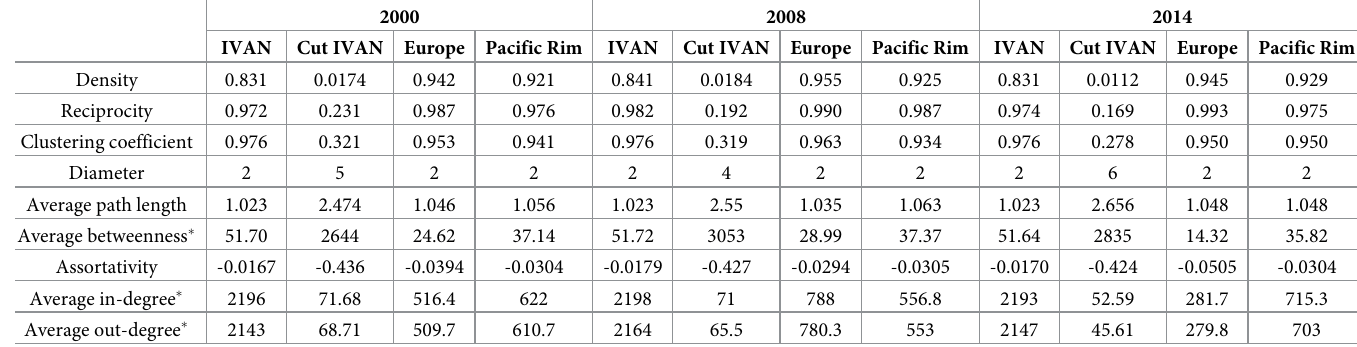
Table 2. Structural characteristics of IVANs, IVANs cut with the threshold, IVANs in the regional communities: Europe and the Pacific